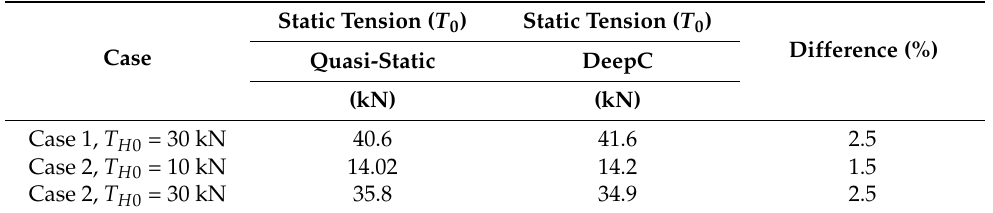
Table 18. Comparison between the quasi-static results with the DeepC static model on T 0